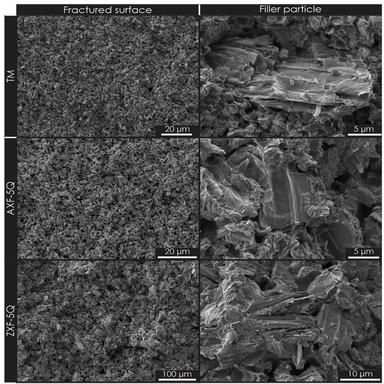
SEM fractography micrographs of POCO graphite grades.